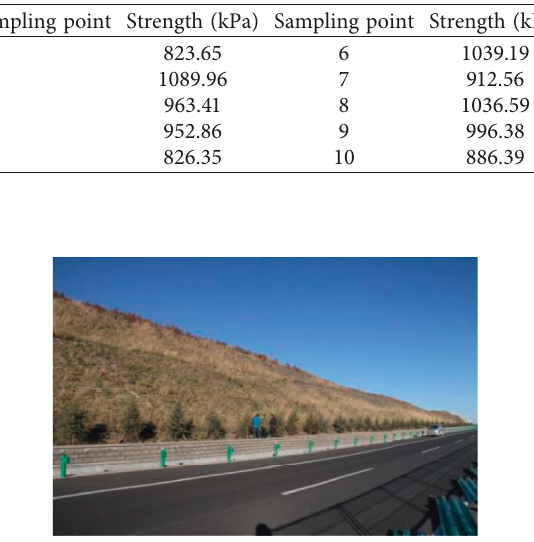
Figure 10: Solidification effect of the sandy slope after two